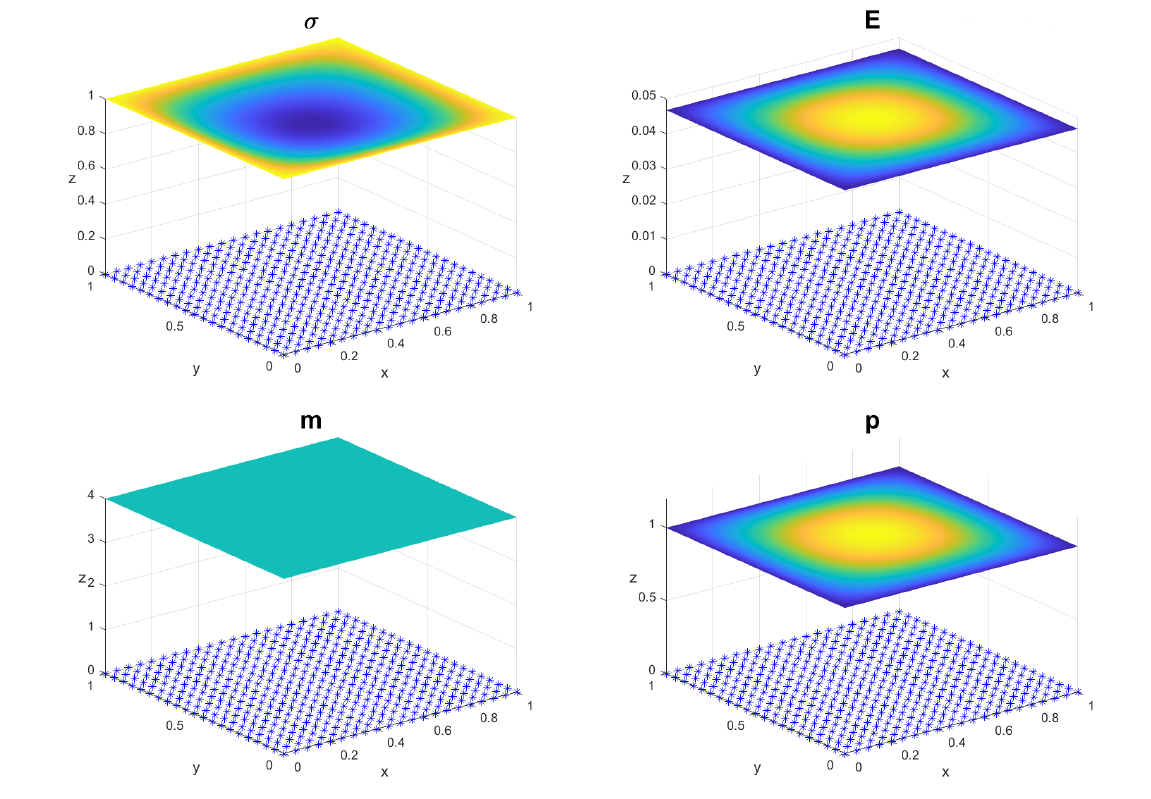
Figure 2. Graphs of the functions: σ , E , m and p for t = 2 s.